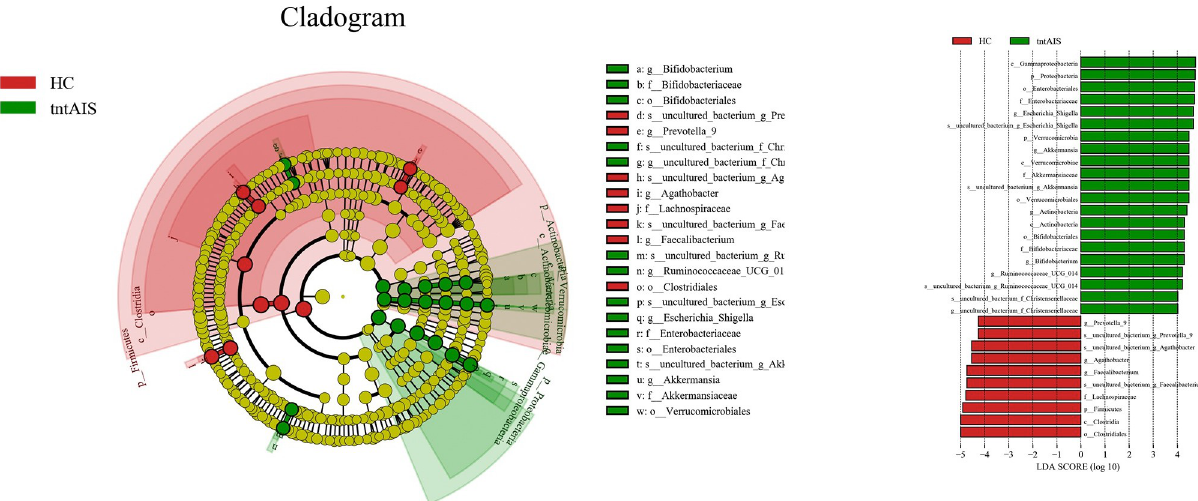
Fig 8. Levels differ significantly between HC and tntAIS groups by LEfSE analysis. AIS: Acute ischemic stroke, tAIS: Patients with PHS, ntAIS: Patients with non-PHS, tntAIS: A combination of patients with PHS and non-PHS, HC: Healthy controls. The LDA score was obtained by LDA (linear regression analysis); the larger the LDA score, the greater the influence of species abundance on the difference effect.